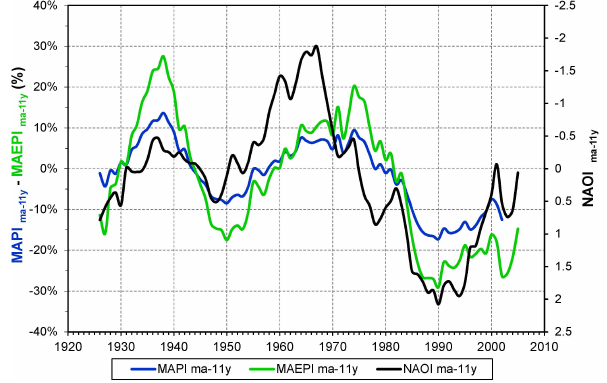
Fig. 3. Comparison of the 11-yr moving averages of the winter NAOI, MAPI, MATI and MAEPI time series for the Campania region.